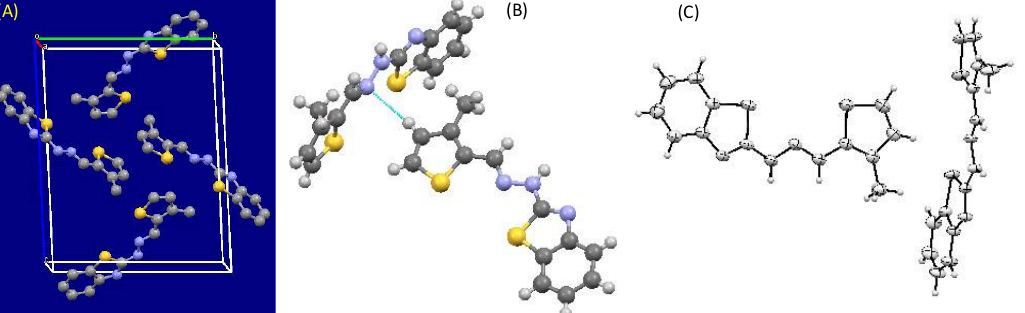
Figure 4. ( A ) View along the a* axis displaying the packing of molecules in monoclinic fashion, ( B ) Van der Waal interaction present between two molecules, and ( C ) ORTEP diagram of Comp2 (ellipsoids at 40% probability).